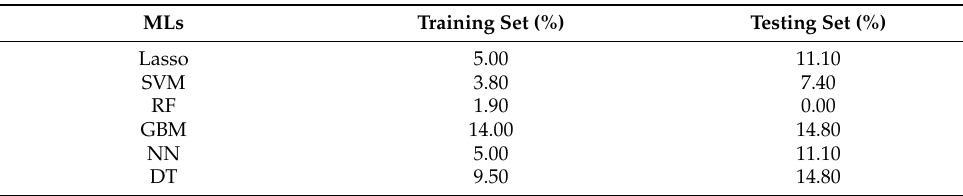
Table 1. The error rate of the six MLs.